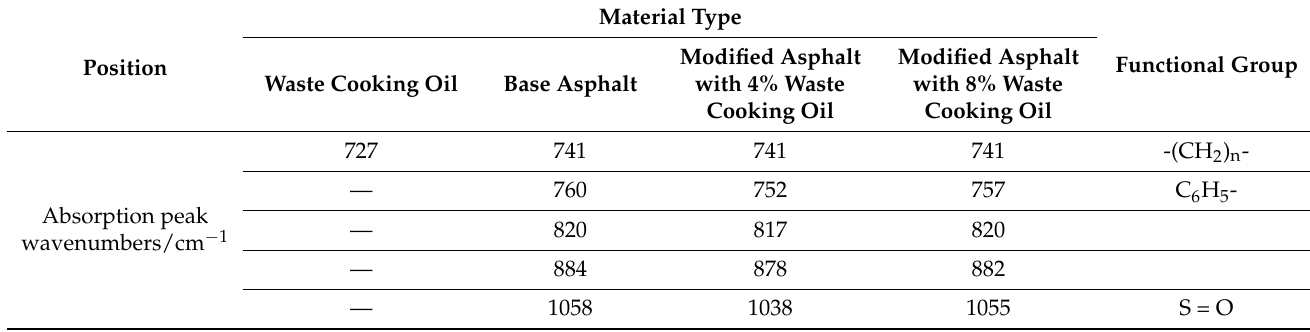
Table 4. Wave number and functional group of absorption peak